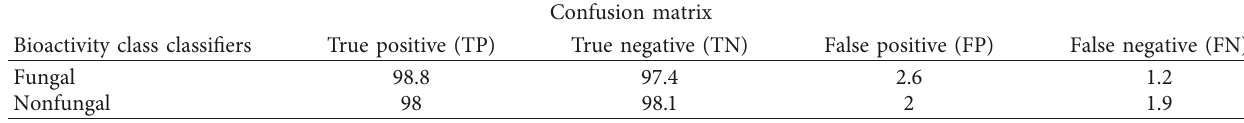
Table 3: Confusion matrix performance measure.